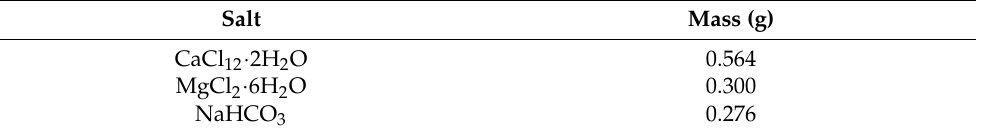
Table 2. The salts and amount in grams used to make 2 litres of 15 dH hard water.